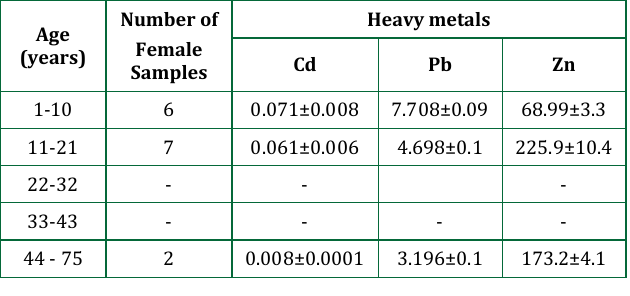
Table 3: Concentration (mg/kg±SD) of Heavy Metal in Female Samples by Age.